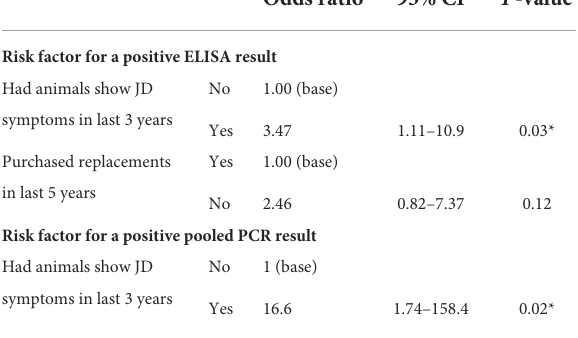
TABLE 11 Summary of herd level multivariable regression analysis examining associations between potential risk factors and testing outcomes from a subset of 108 herds providing additional